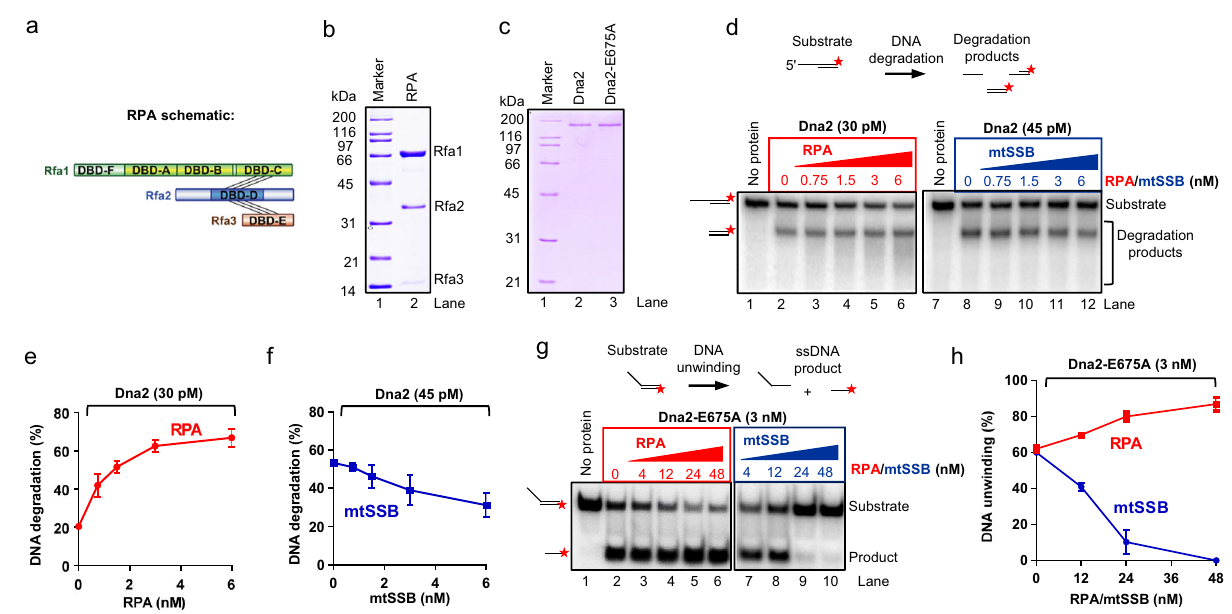
Fig. 1 RPA speci fi cally promotes both helicase and nuclease activities of Dna2. a A schematic of RPA. b Puri fi ed wild-type RPA used in this study. c Recombinant S. cerevisiae Dna2 and Dna2-E675A (nuclease-dead) variants used in this study. d Yeast RPA and human mitochondrial SSB (mtSSB) were used in nuclease assays with Dna2 and 5 ′ - overhanged DNA substrate (45 nt ssDNA, 48 bp dsDNA, 1 nM, in molecules). The red asterisk indicates the position of the radioactive label. e , f Quanti fi cation of nuclease assays such as shown in panel d . Error bars, SEM; n = 3. g Yeast RPA and mtSSB were used in helicase assays with Dna2-E675A and 5 ′ -overhanged DNA substrate (30 nt ssDNA, 31 bp dsDNA, 1 nM, in molecules) with 50 mM KCl. h Quanti fi cation of assays such as shown in panel g . Error bars, SEM; n =